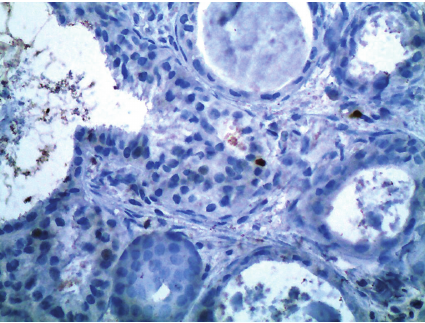
Figure 5: Less than 1% of lesional cells were immunoreactive for Ki- 67 antibody ( ×